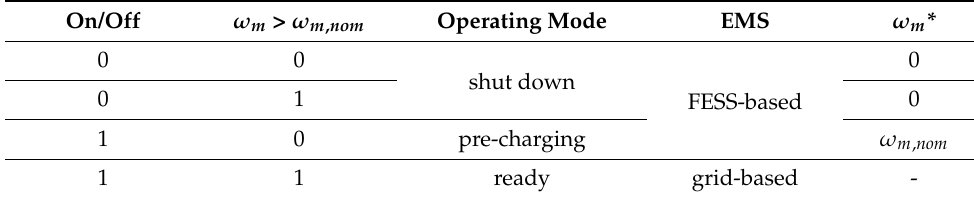
Table 1. FESS operating